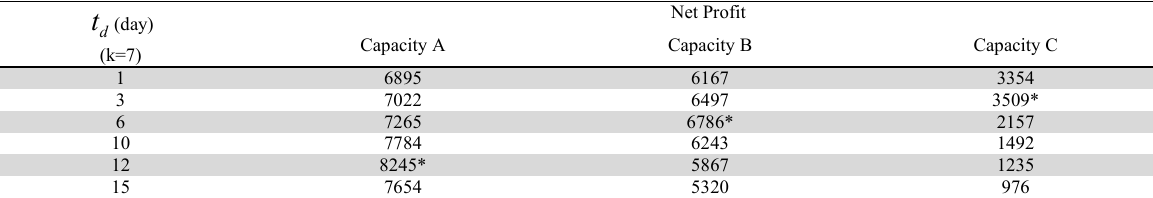
Sensitivity analysis on parameter